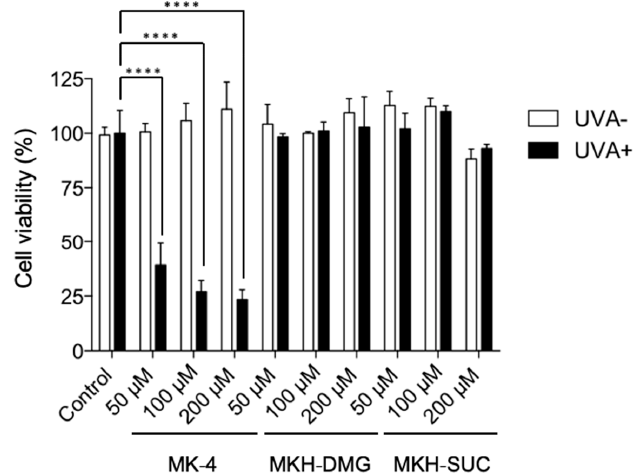
Figure 6. Viability of HaCaT cells treated with MK-4 and MKH-ester derivatives and irradiated with UVA. Cell viability was assessed at 24 h after UVA irradiation (15 J/cm 2 ). Data represent mean ± SD ( n = 3). **** p < 0.001 by Dunnett’s